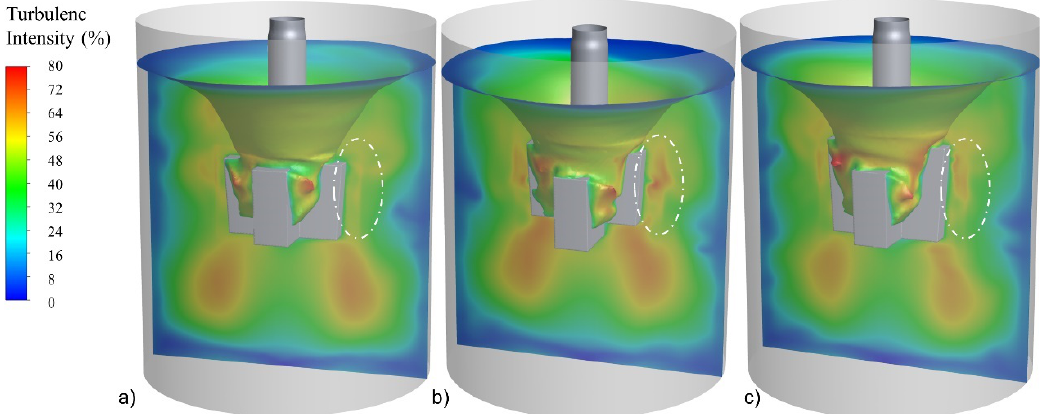
Figure 4. The turbulence intensity of the molten iron. ( a ) impeller model 1, ( b ) impeller model 2, ( c ) impeller model 3.